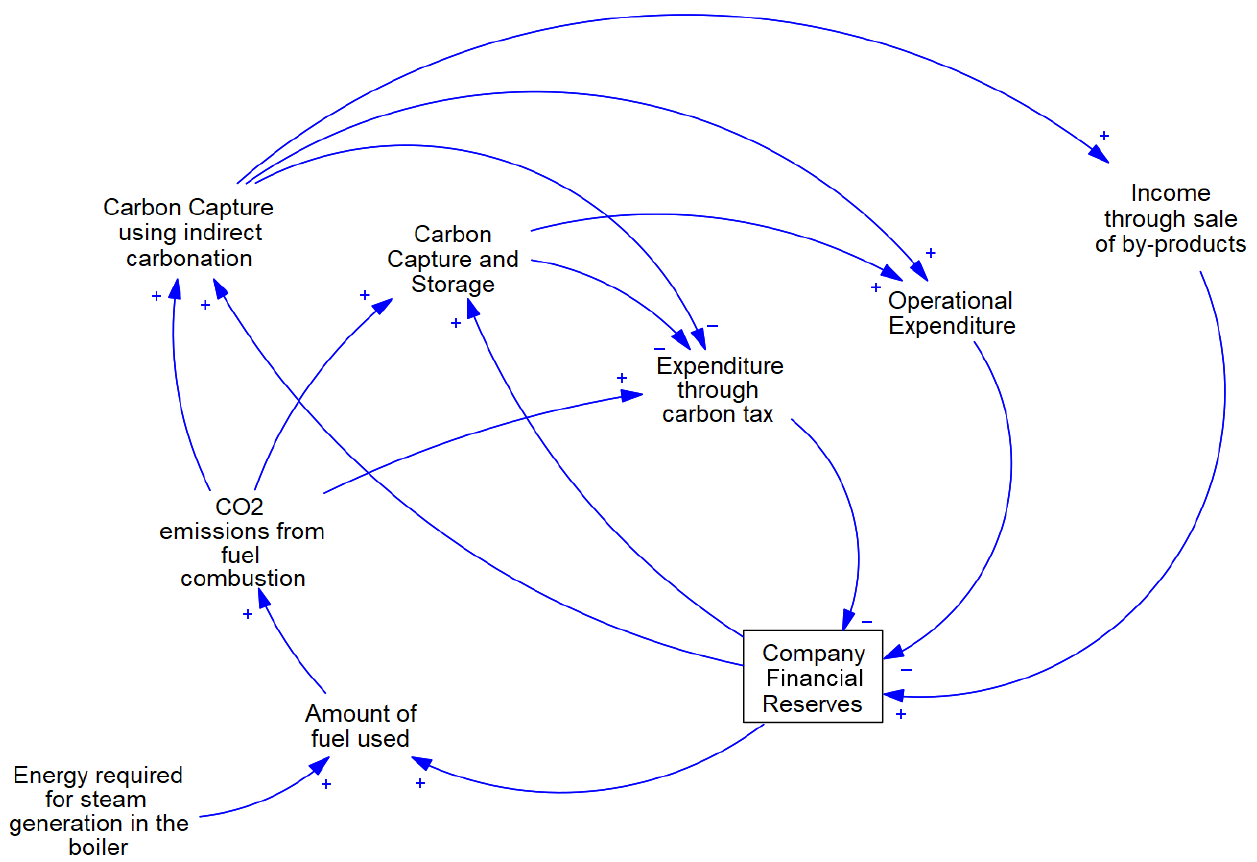
Figure 4. CLD of the Carbon Capture Module for CO 2 emissions capture.